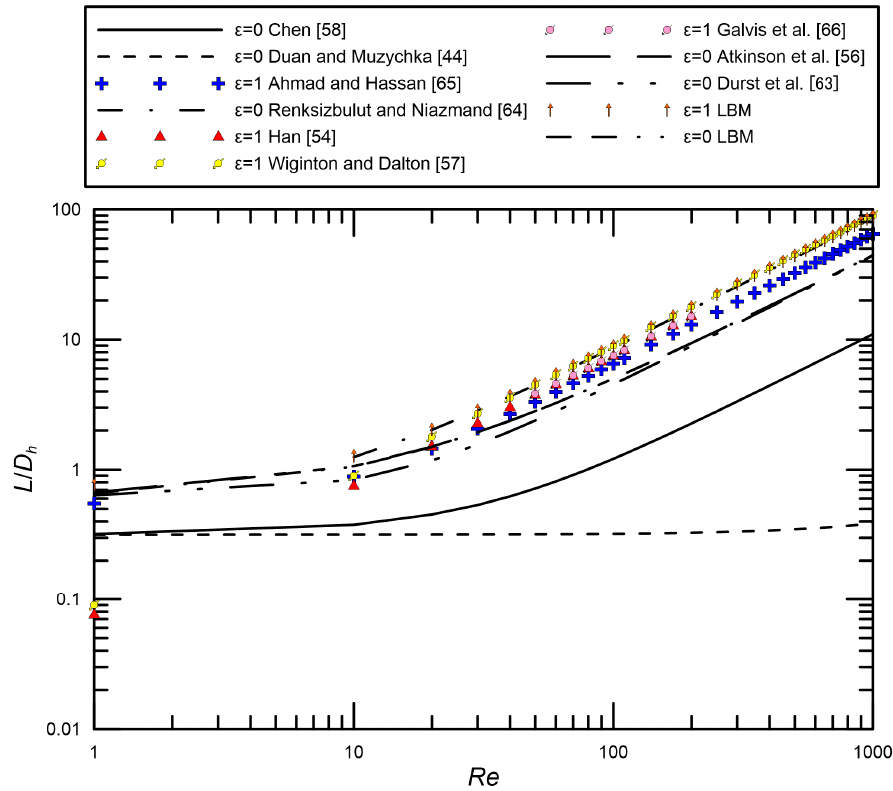
Figure 7. Comparison of current data and correlations for entrance length from the literature.